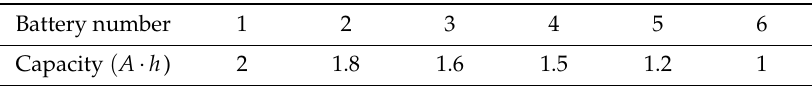
Table 2. The number and capacity of test batteries.